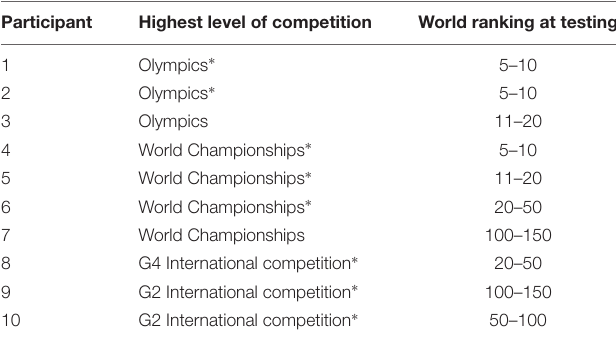
TABLE 1 | Highest level of competition and world ranking range for each